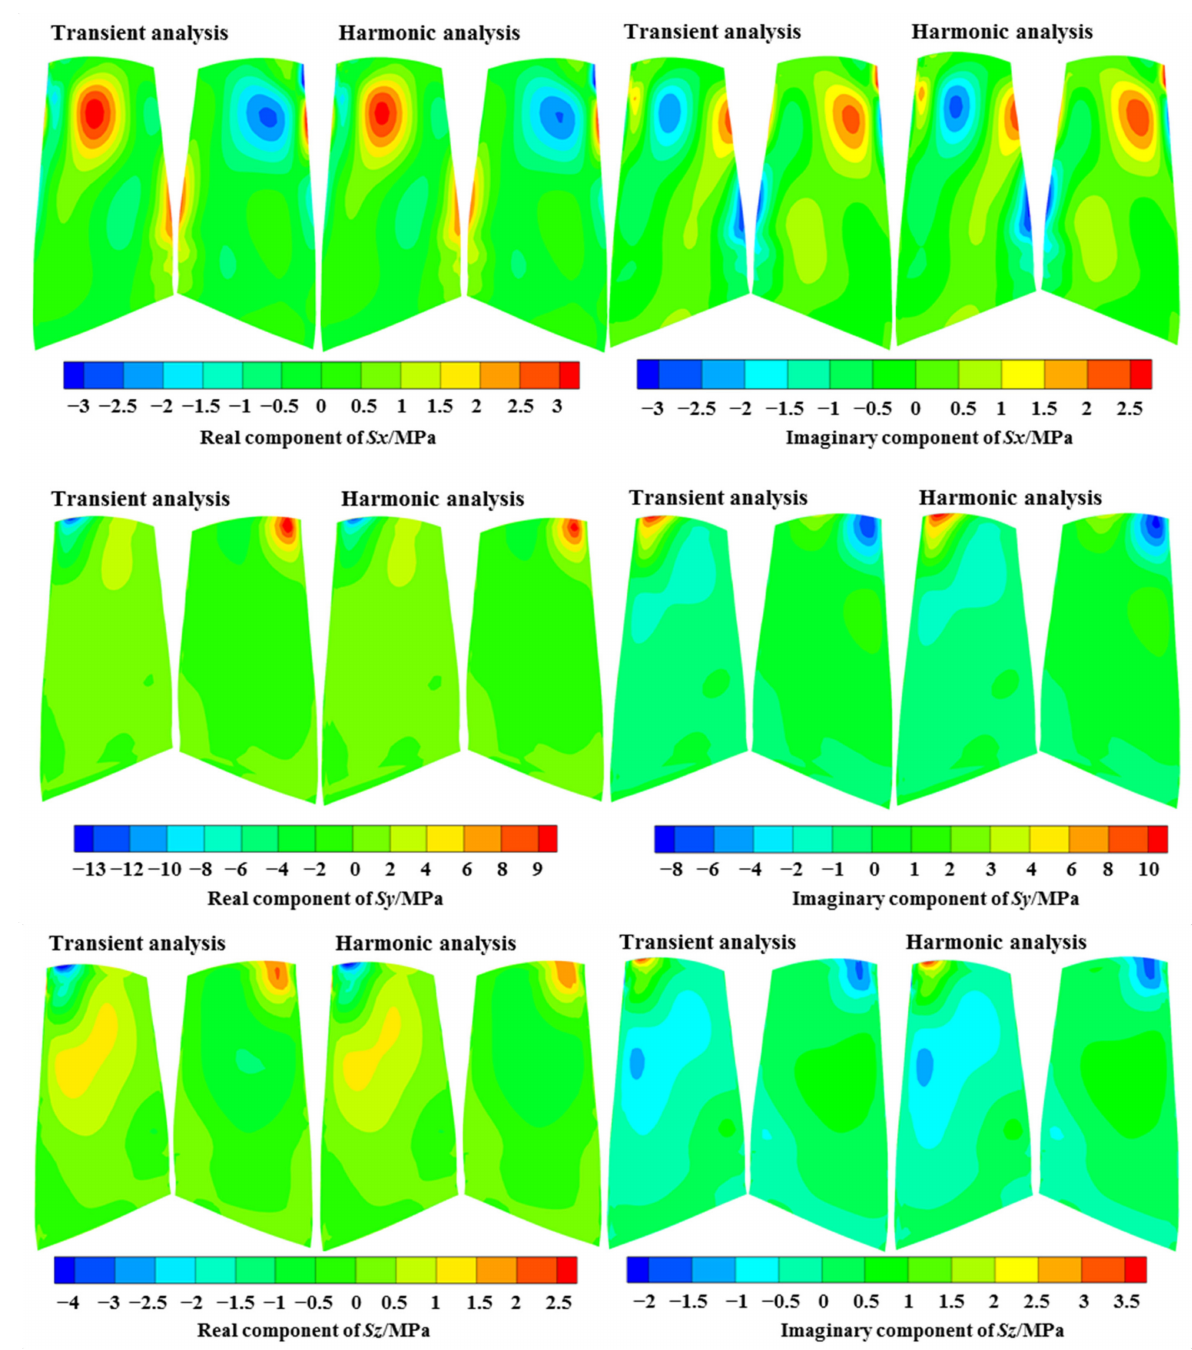
Figure 21. Comparison of the normal stress